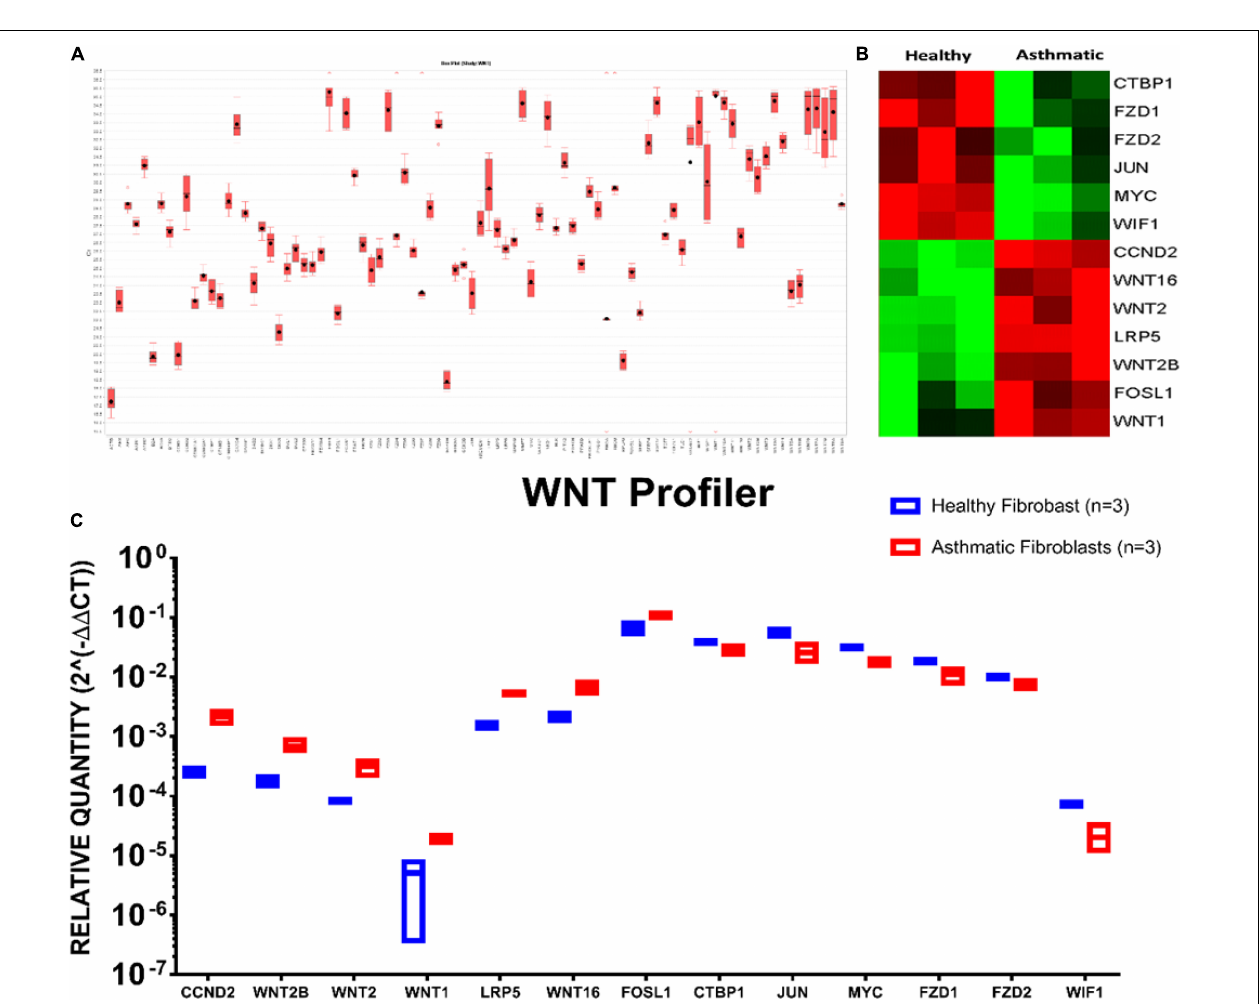
FIGURE 6 | Wnt signaling gene expression profiling in healthy versus asthmatic bronchial fibroblasts. Fibroblasts from healthy controls and asthmatic patients were seeded in triplicate, and when reaching 80–90% confluency, RNA was extracted, and Wnt genes were profiled using RT 2 ProfilerTM PCR Array Human WNT Signaling Pathway. (A) Box plot of relative expression of each gene member of the pathway. (B) Heat map showing the top DEGs between the two groups. (C) The relative quantity of the DEGs between healthy fibroblasts and asthmatic ones.